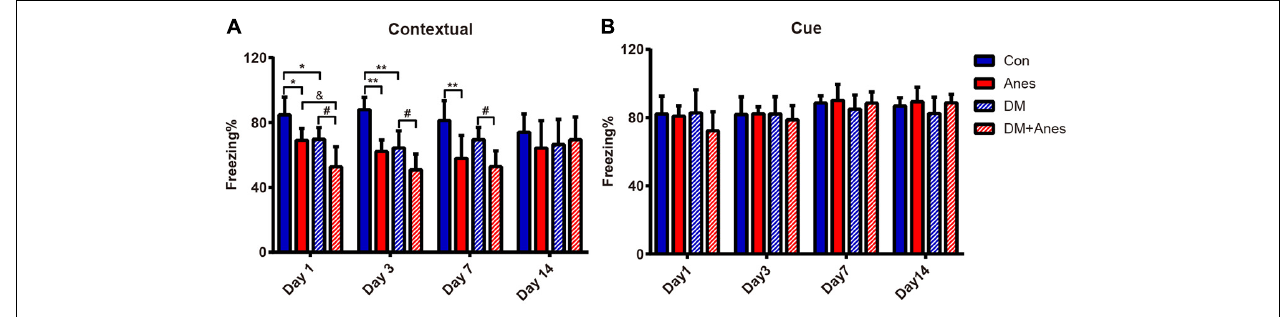
FIGURE 2 | Isoflurane inhalation selectively impairs contextual fear memory and this effect is exacerbated in diabetic mice. (A) Freezing (% time) in response to the foot-shock context (chamber) among adult WT mice and T2DM mice (DM groups) exposed to 1.3% isoflurane inhalation for 6 h (Anes and DM + Anes groups) or control inhalation (100% O 2 for 6 h). (B) Freezing time during exposure to the conditioned sound cue in a different context. Data are expressed as mean ± SD of 7–8 mice for each treated group and analyzed with one-way ANOVA test followed by Bonferroni multiple comparison test. ∗ P < 0.05 and ∗∗ P < 0.01 vs. Con group; & P < 0.05 vs. Anes group; # P < 0.05 vs. DM